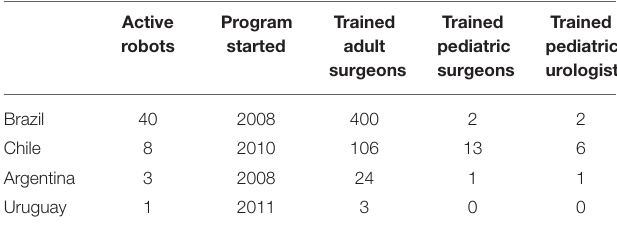
TABLE 3 | Description of Robot programs in South